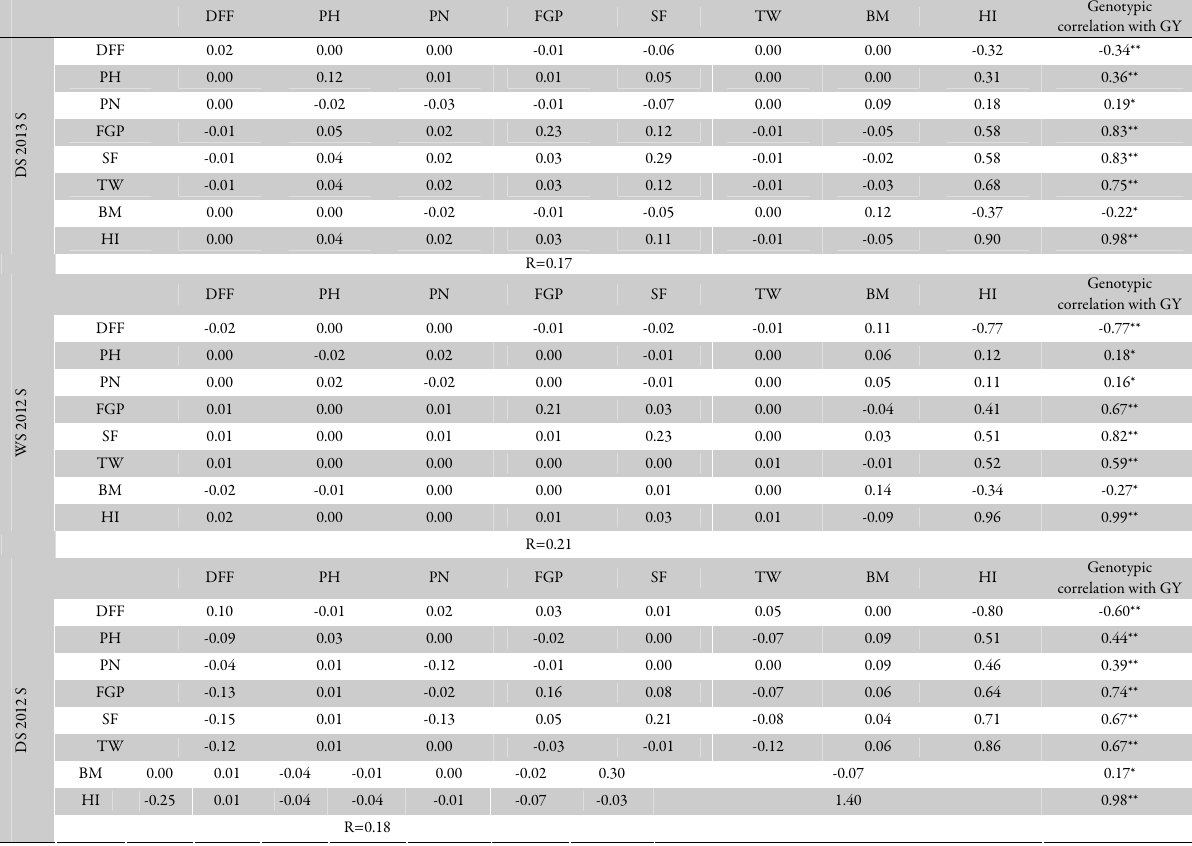
Tab. 4a. Direct (diagonal values) and indirect effects of different characters on grain yield at genotypic level under stress DS 2013, WS 2012 and DS